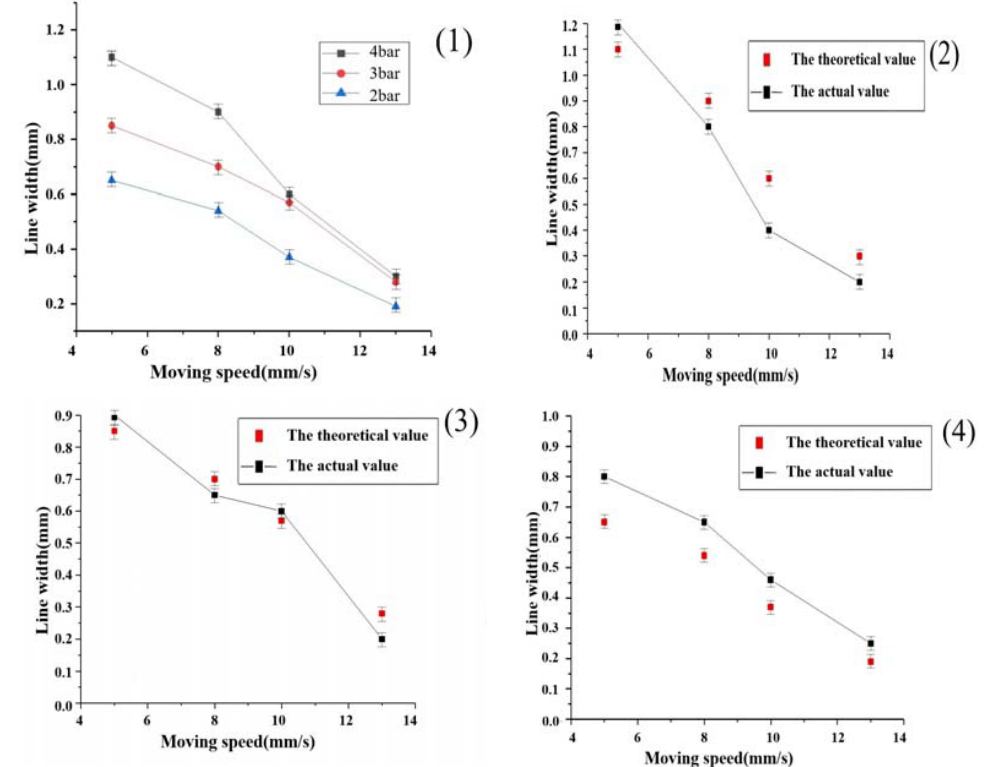
Figure 9. Printhead movement speed on the impact of print line width: ( 1 ) different pressure print- head movement speed—line width overall trend graph; ( 2 ) 4 bar pressure under theoretical—actual line width comparison graph; ( 3 ) 3 bar pressure under theoretical—actual line width comparison graph; ( 4 ) 2 bar pressure under theoretical—actual line width comparison graph).